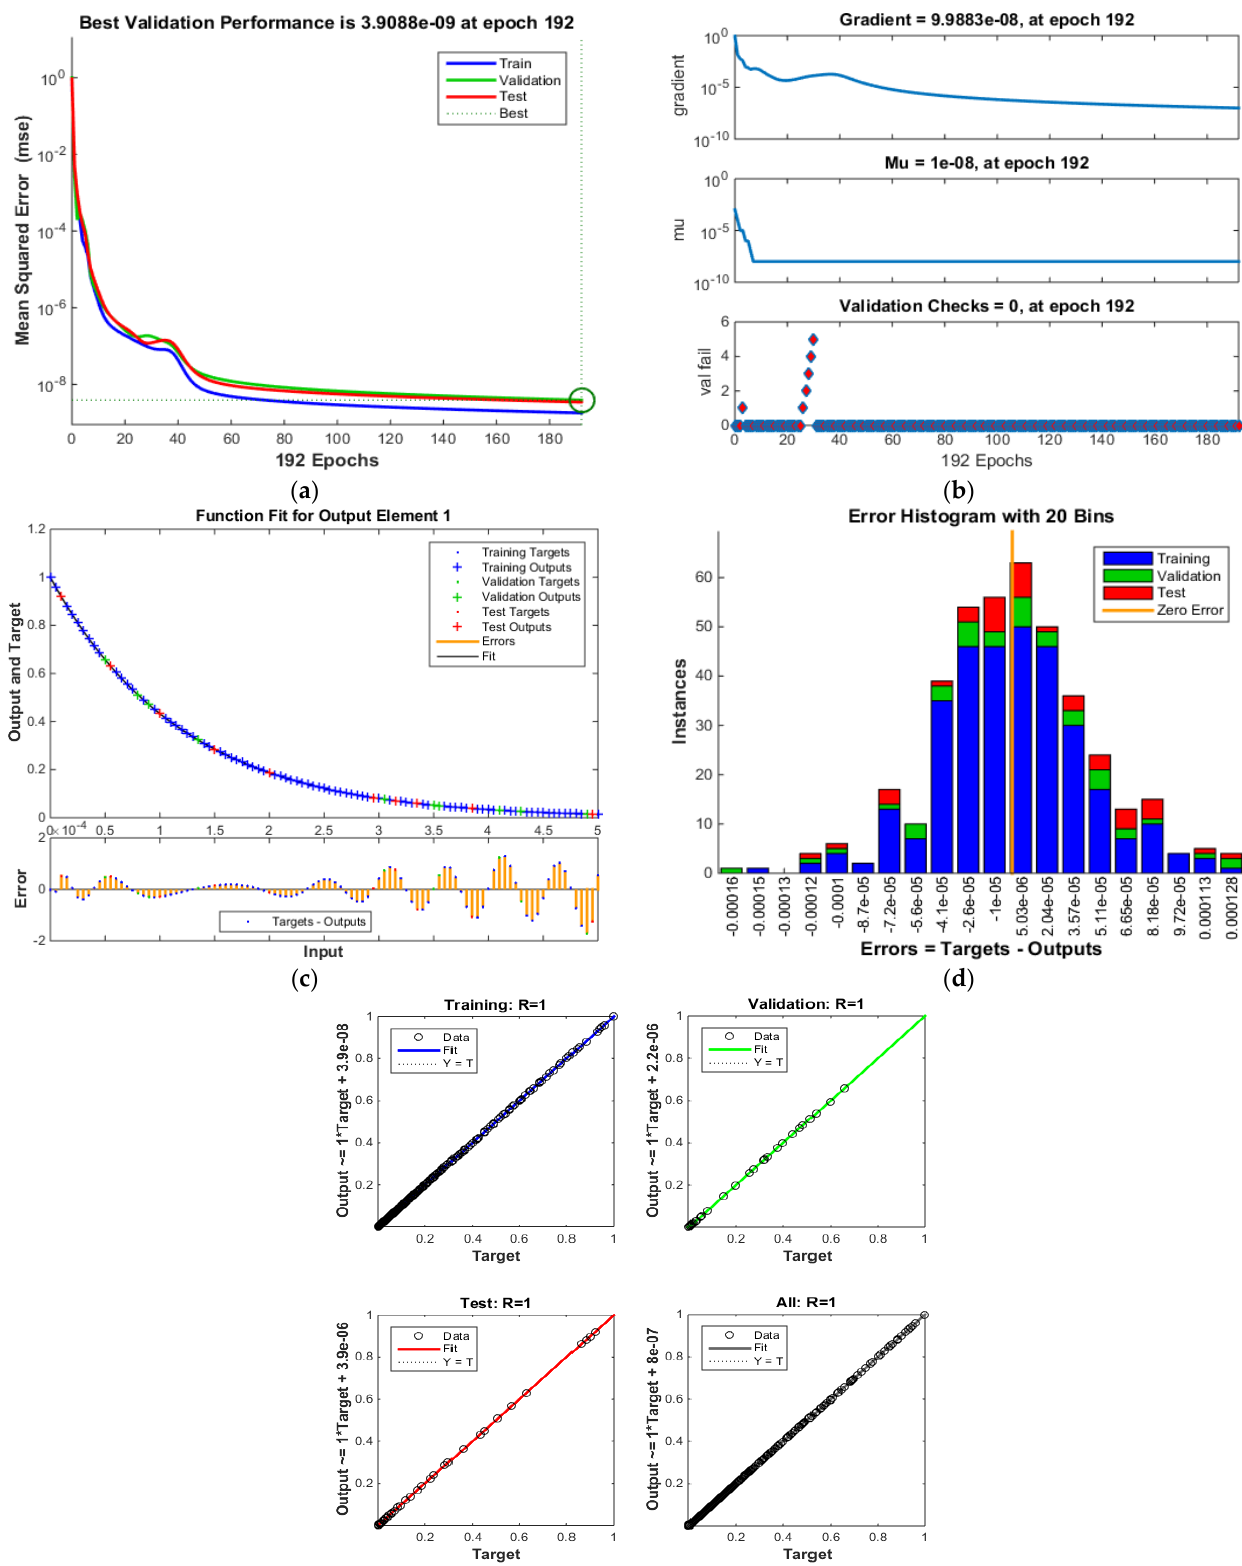
Figure 12. Graphic representation for designed LMT-ABPNN for solving cases of Sc for φ ( η ) of MHD-SGFM. ( a ) MSE Result, ( b ) Results of the transition state, ( c ) Fitness of the curve, ( d ) Histogram for error analysis, ( e ) Regression.